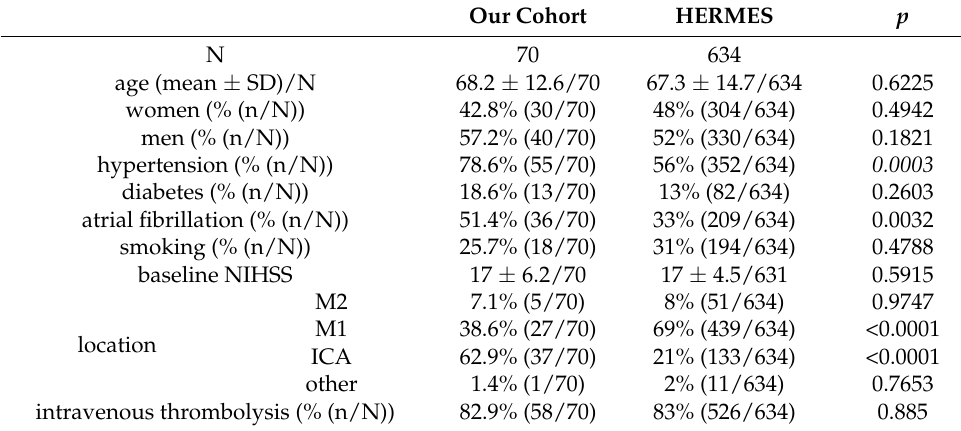
Table 1. Baseline clinical patient characteristics of both groups (mean age, men, women, hypertension, diabetes mellitus, atrial fibrillation, known history of smoking, baseline